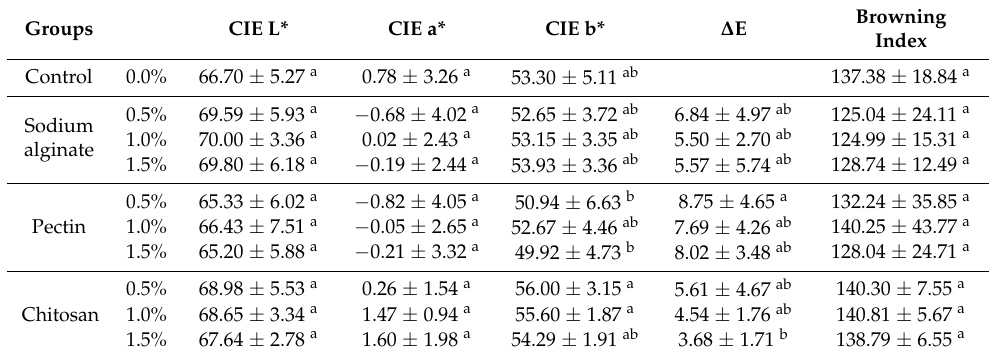
Table 2. Color values in sodium alginate, pectin- or chitosan-added biscuits in different concentrations.